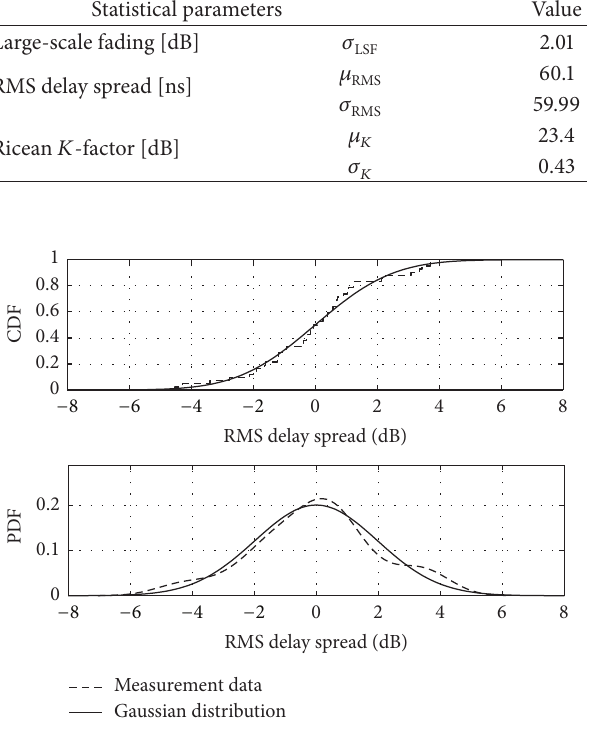
Figure 11: CDF and PDF of the RMS delay spread, together with a Gaussian